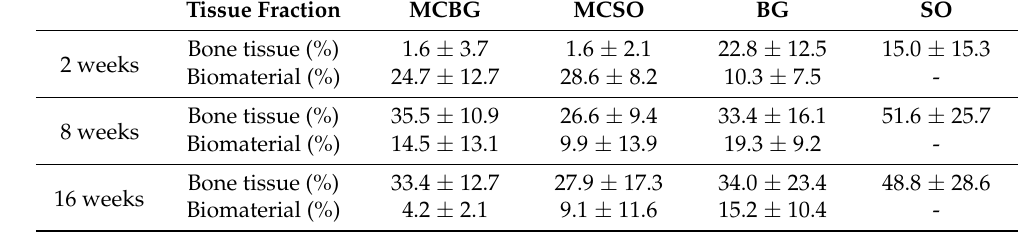
Table 1. Histomorphometrical measurement results of the tissue distribution. Values are the per- centage of the TIA. MCBG: membrane compartment above bone graft-filled bone defects; MCSO: membrane compartment above sham operation; BG: bone graft-filled bone defect; and SO: sham operation bone defects.